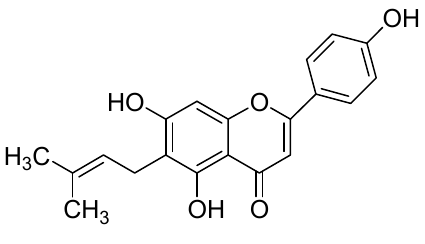
Figure 18. 6-Prenyl apigenin.